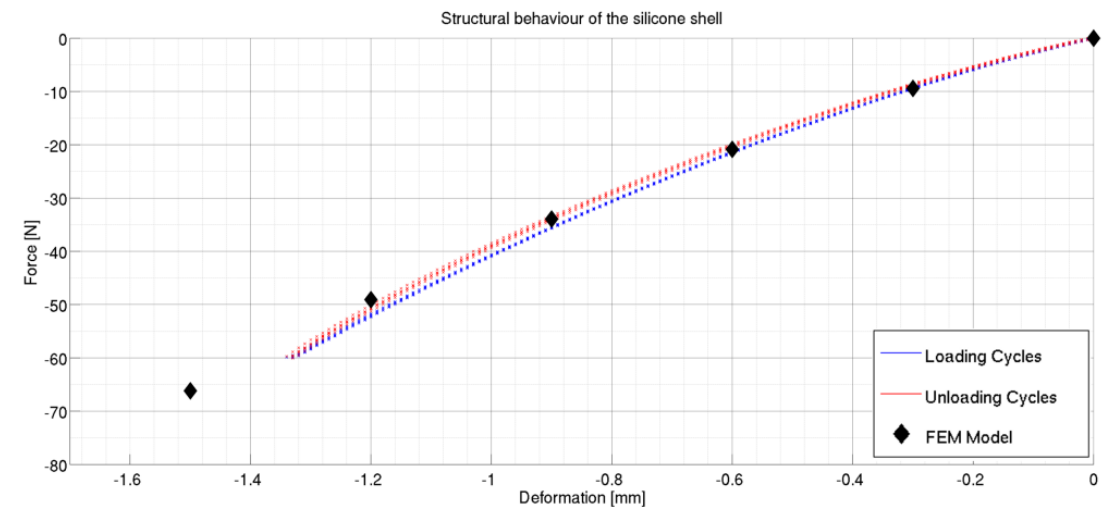
Figure 4. Force/Deformation characterization of the pad, after five loading-unloading